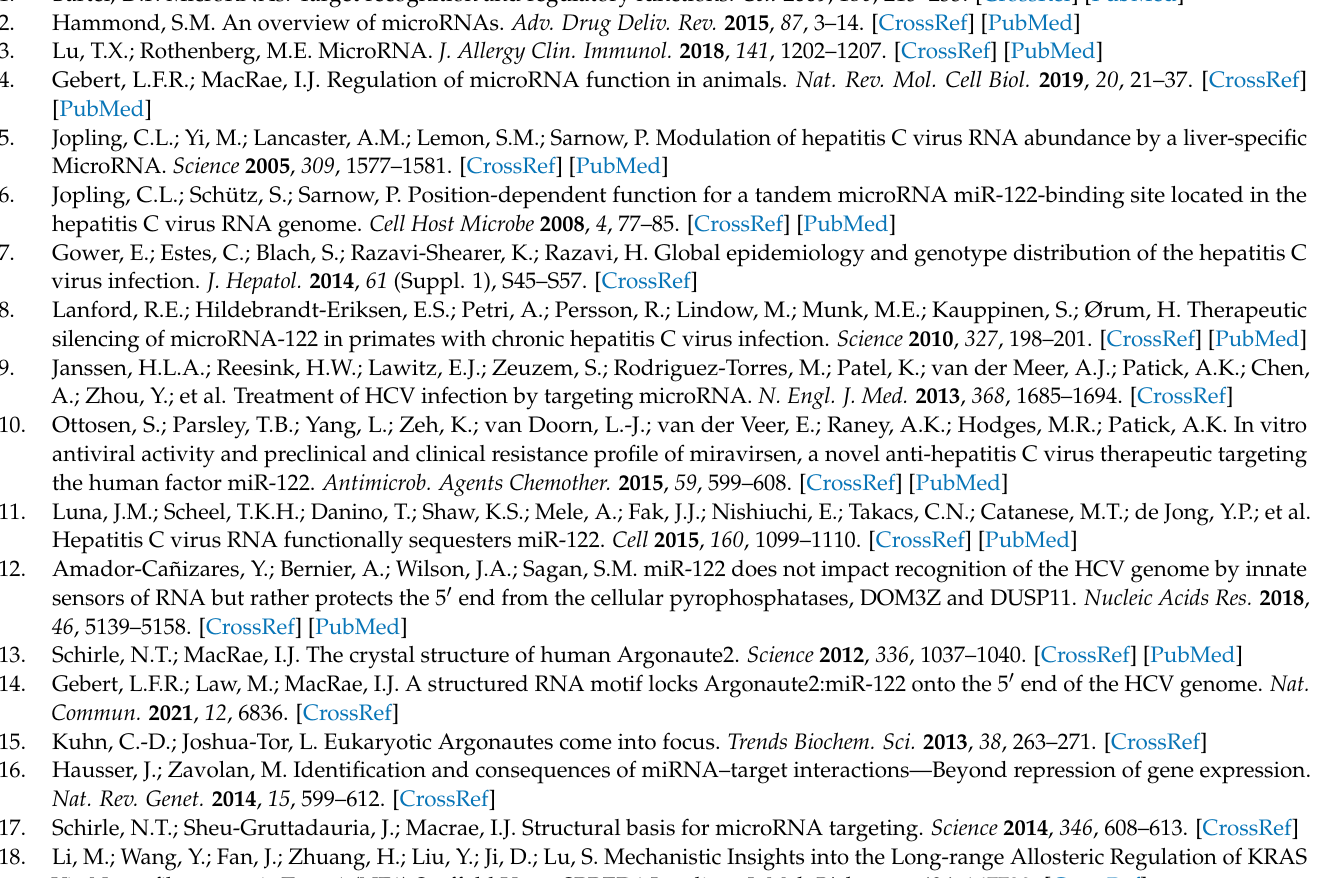
complex; Figure S3: The representation of dE333–V610 and dE333–P63 in the energy landscape; Figure S4: The MSM timescale and Chapman Kolmogorov tests; Figure S5: The number of hydrogen bonds of the target RNA with the Ago2 protein and